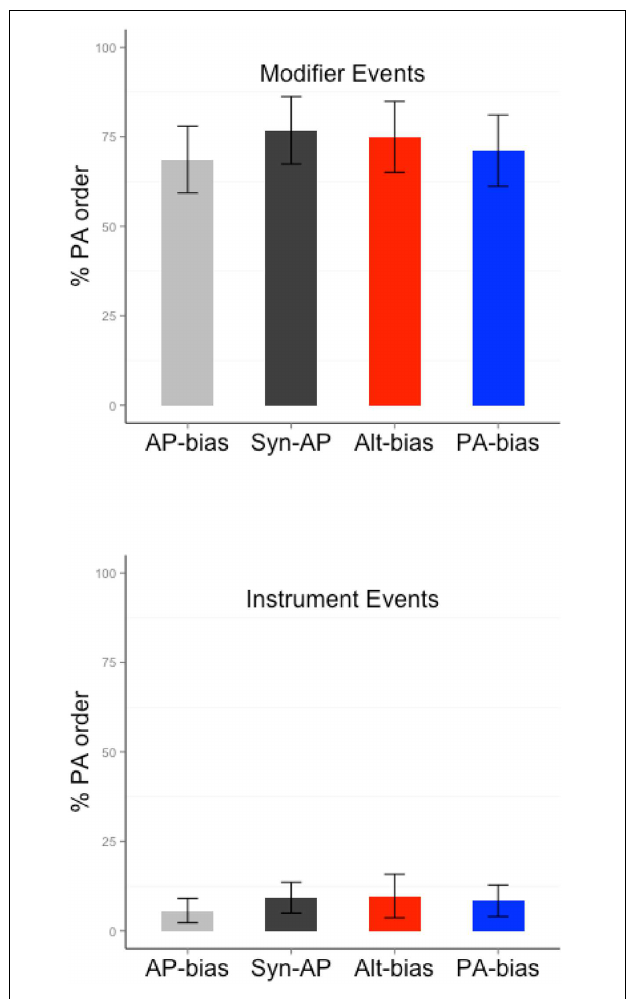
FIGURE 5 | Proportion of PA order responses produced with different verb and event types in Experiment